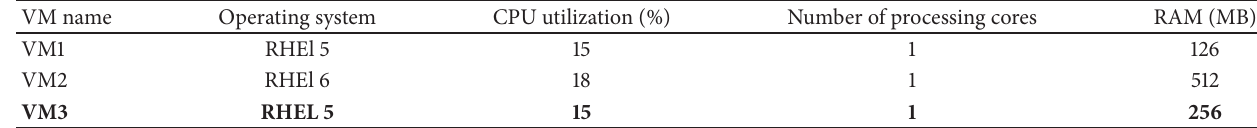
Table 22: Local list of node 3 (S2).